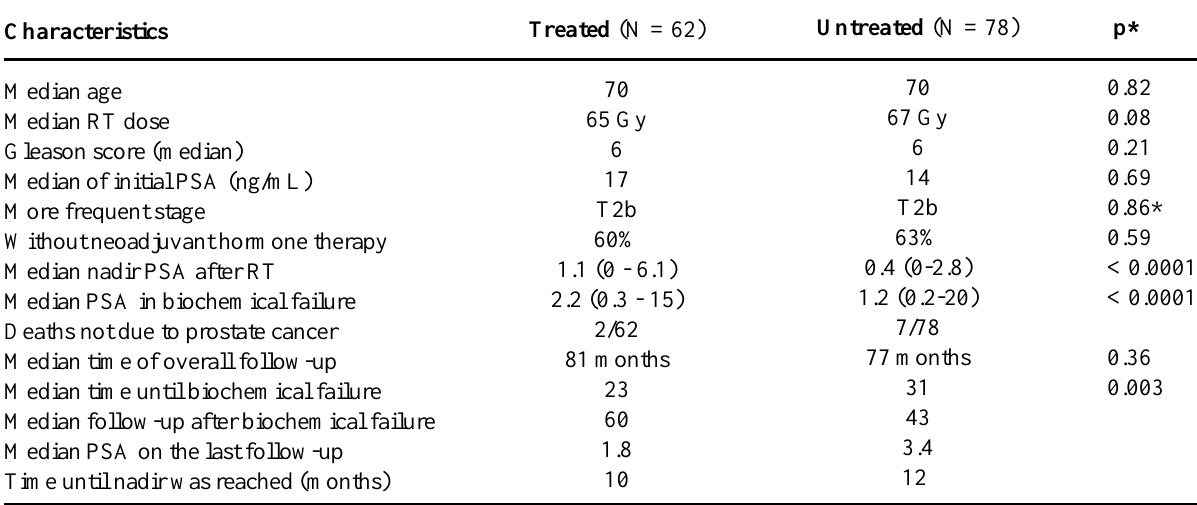
Table 1 – Characteristics of 140 among 207 patients with biochemical failure following radical radiotherapy (RT) for localized prostate cancer. All patients were asymptomatic and had negative computerized tomography or bone scintigraphy or did nor undergo any of these testes because they had a highly favorable clinical condition. One group (n = 62) received hormone therapy and the other (n = 78) was exclusively followed without